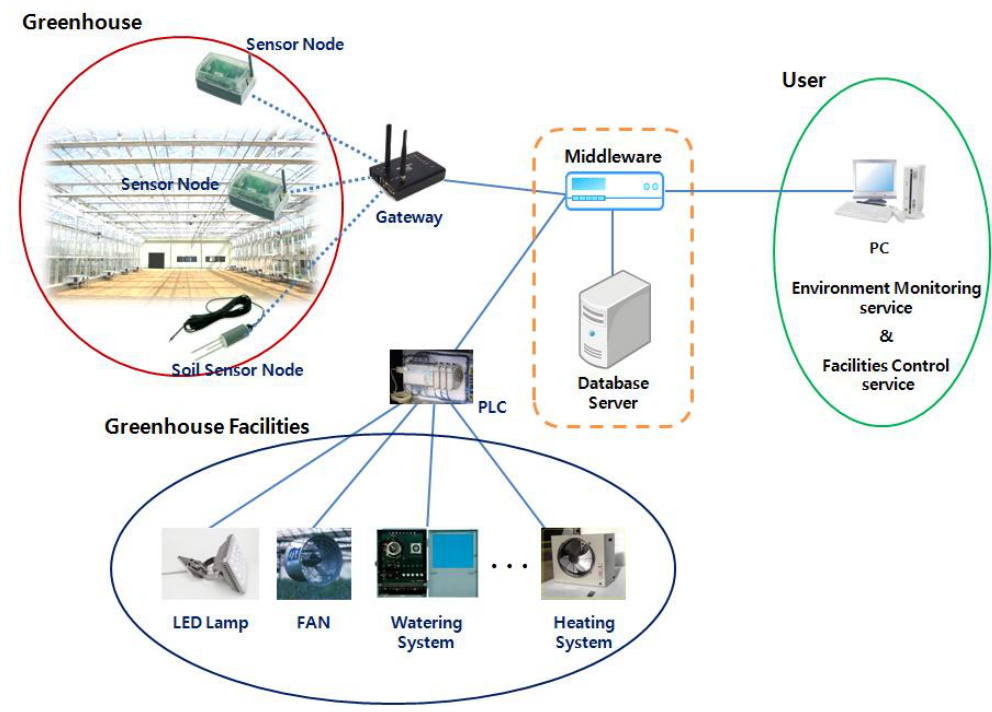
Figure 1. System structure of a ubiquitous greenhouse.